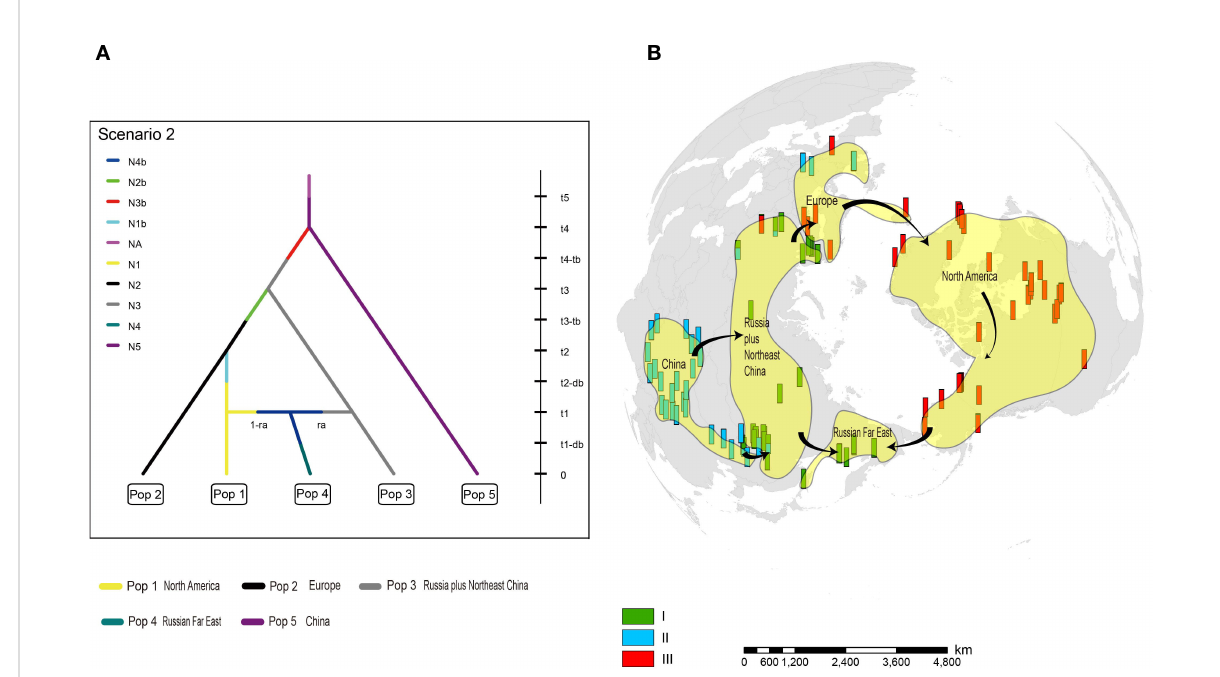
FIGURE 4 The origin and dispersal of Hippuris vulgaris . (A) The best fi t model (Scenario 2) of divergence within H. vulgaris analysed by ABC-RF. (B) Most likely scenario of dispersal routes for H. vulgaris to attain a circumarctic